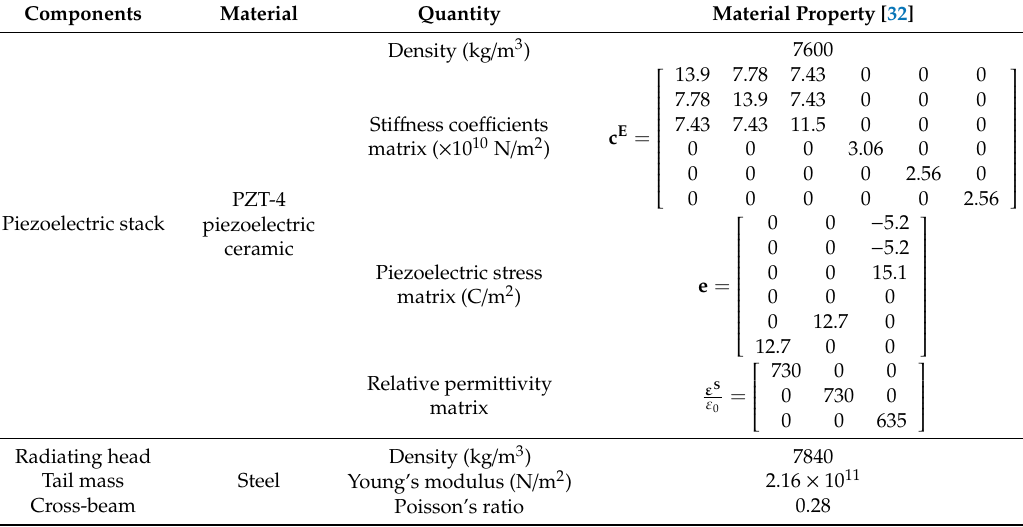
Table 1. Material properties of cascade-connected transducer.